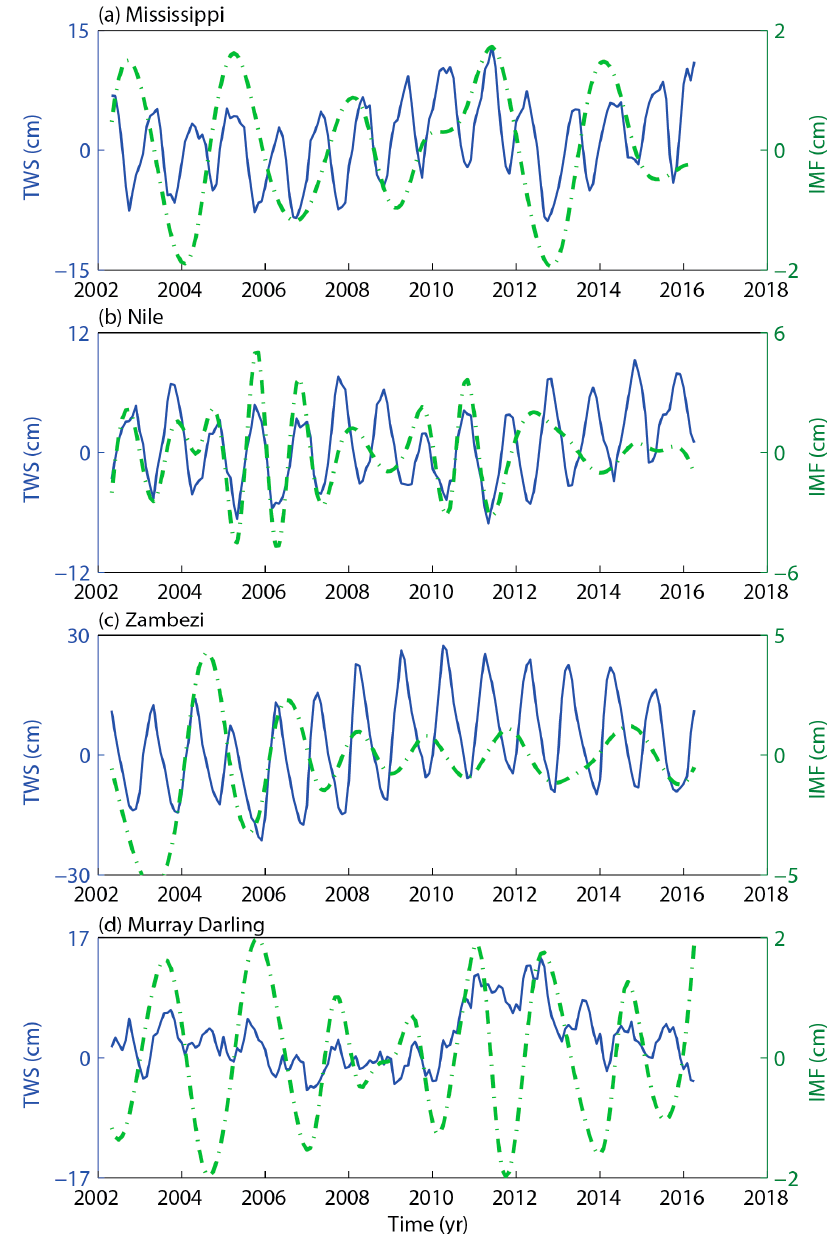
Figure 3. Comparison between TWSA (solid line) and the extreme indicator IMF (dashed line) identified for ( a ) Mississippi, ( b ) Nile, ( c ) Zambezi, and ( d ) Murray-Darling river basins.